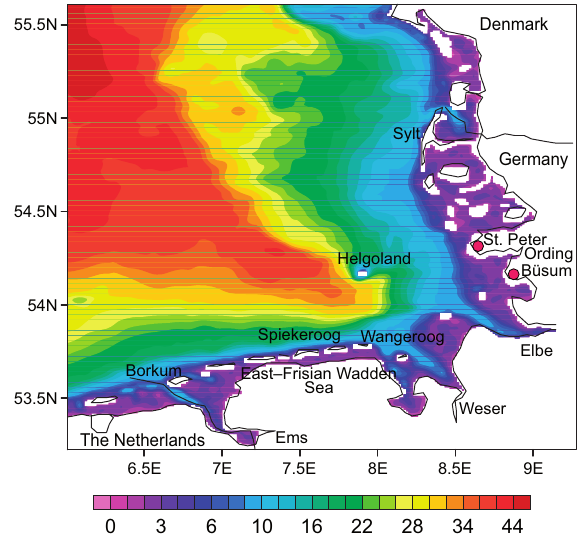
Fig. 1. Topography of the German Bight. Depths are in (m).